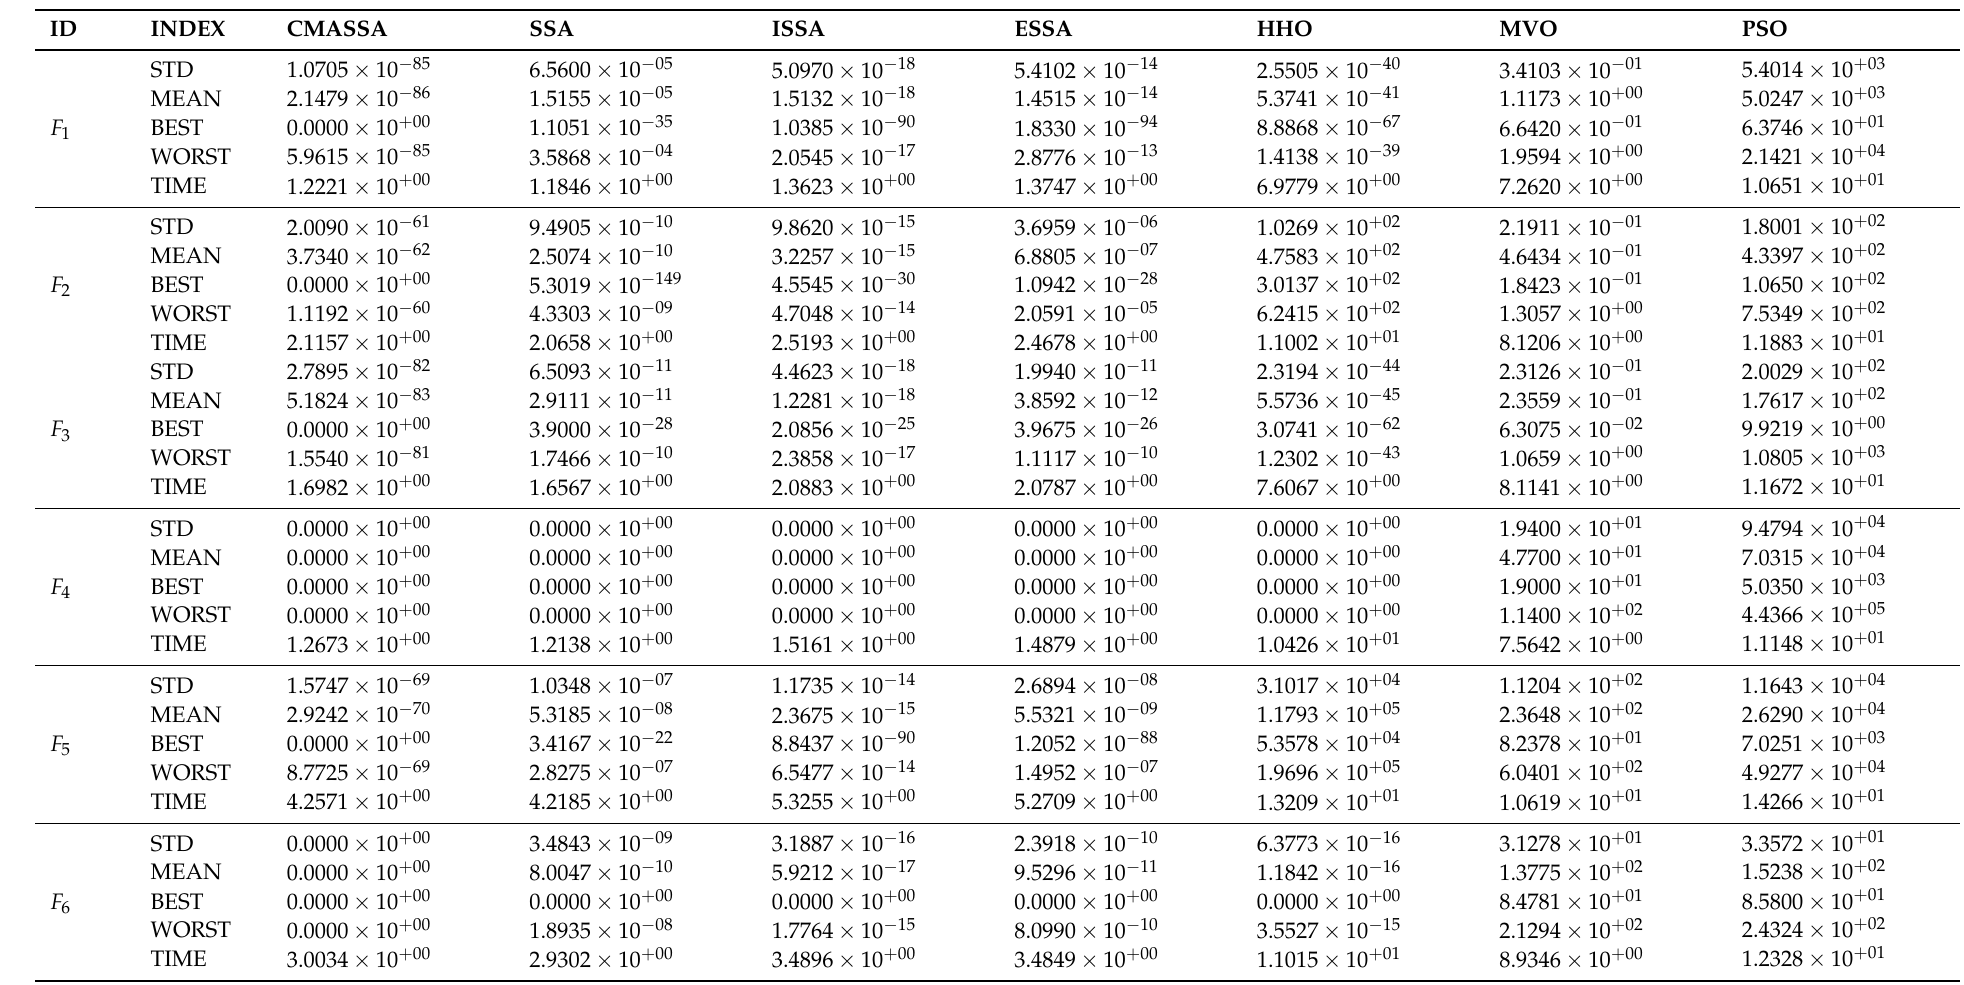
Table 3. Comparison of results of optimization algorithm test benchmark